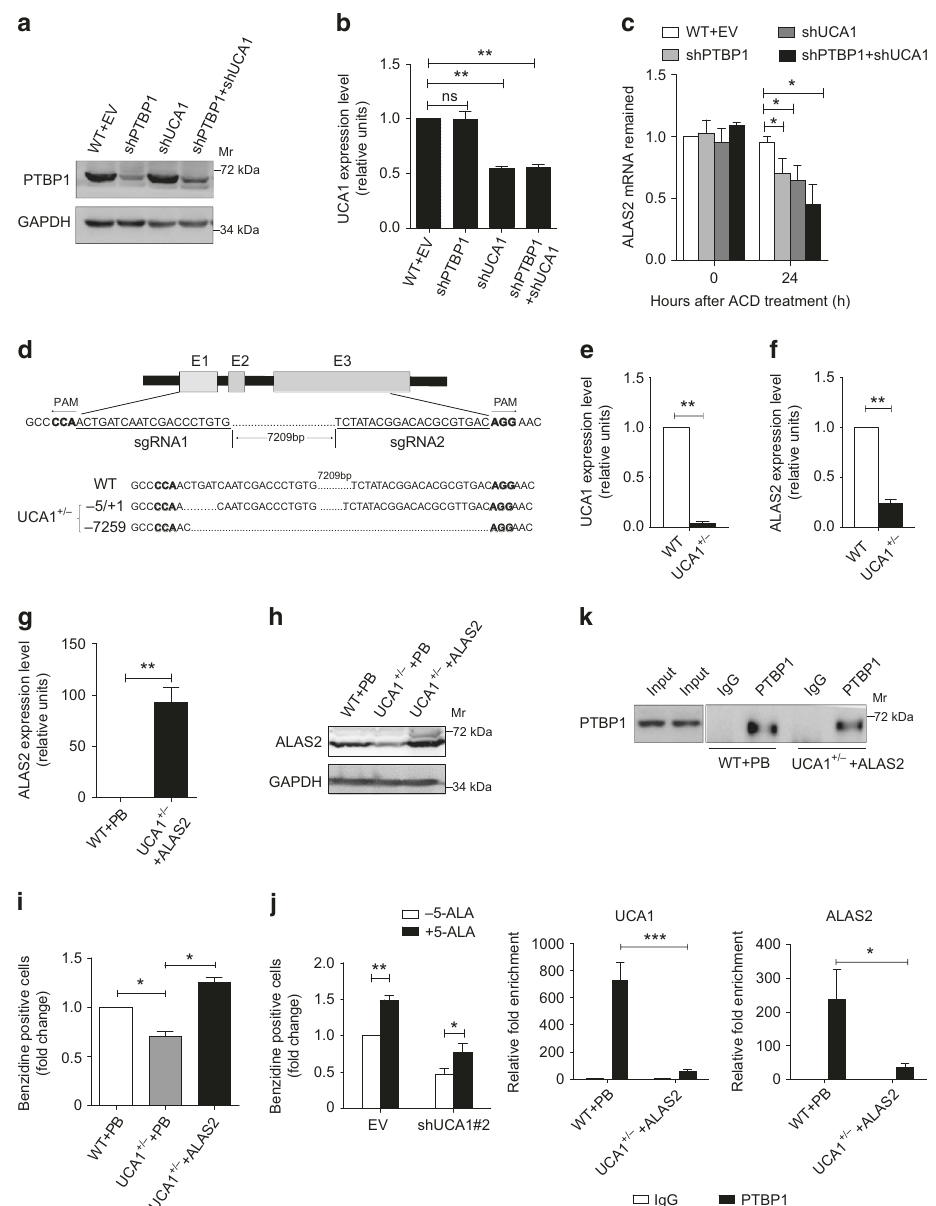
Fig. 6 UCA1 is indispensable for PTBP1 regulation of ALAS2 mRNA stability. a – c ALAS2 mRNA stability assessment. K562 cells were infected with lentiviral control vector (EV), sh UCA1 , shPTBP1, and sh UCA1 + shPTBP1 after induced by AraC for 24 h. The cells were treated with Actinomycin D (5 μ g per ml) for 24 h to quantitate ALAS2 mRNA stability. The expression of PTBP1 and UCA1 was quantitated by WB ( a ) and qRT-PCR ( b ), respectively. The ALAS2 mRNA abundance, relative to GAPDH , was quanti fi ed by qRT-PCR ( c ). d Schematic illustrating UCA1 deletion using CRISPR/Cas9 technology in K562 cells (top). UCA1 compound heterozygous mutant cell line ( UCA1 + /- ) was con fi rmed by DNA sequencing (bottom). e , f The relative abundance of UCA1 ( e ) and ALAS2 ( f ) mRNA was quanti fi ed by qRT-PCR in WT and UCA1 + /- cells, respectively. g , h The overexpression of ALAS2 mRNA ( g ) and protein ( h ) was measure by qRT-PCR and WB, respectively. ALAS2 piggybac transposon expression vector or the empty piggybac vector (PB) were transfected to WT or UCA1 + /- K562 cells. GAPDH mRNA and protein was used for internal control for qRT-PCR and WB, respectively. i The relative fold-change of benzidine- positive cells (%) in UCA1 + /- cells with ALAS2 overexpression ( UCA1 + /- + ALAS2) and UCA1 + /- cells with empty piggybac expression vector ( UCA1 + /- + PB) to that of WT K562 cells transfected with empty vector (WT + PB). j The relative fold-change of benzidine-positive cells (%) at day 14 differentiated primary erythroid cells. The cells were fi rst infected with lentiviral control vector (EV) or UCA1 shRNA#2 at day 4 and then 300 μ M 5-ALA was supplemented to the culture medium at day 6. k PTBP1 RIP assay was conducted to test for interaction between PTBP1 and ALAS2 mRNA. WB analysis of PTBP1 immunoprecipitation in WT or UCA1 + /- cells with ALAS2 overexpression (top). The enrichment of UCA1 RNA and ALAS2 mRNA in PTBP1 immunoprecipitates was detected by qRT-PCR in WT and UCA1 + /- cells, respectively, (bottom). n = 3 independent experiments. Error bars represent SEM. P -values were determined by Student ’ s t -test. *P < 0.05. **P < 0.01, ***P <